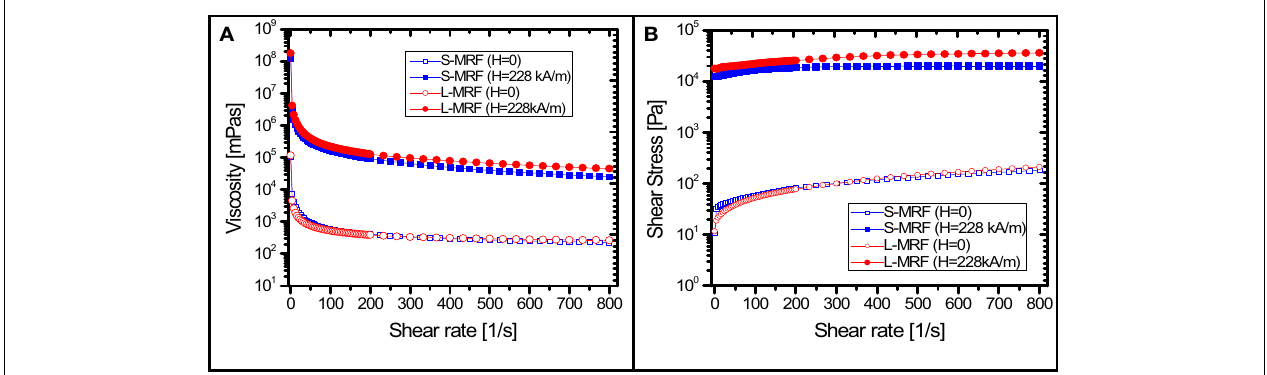
FIGURE 3 |Viscosity (A) and shear stress (B) as a function of shear rate in the absence and presence of maximum magnetic field strength are shown .